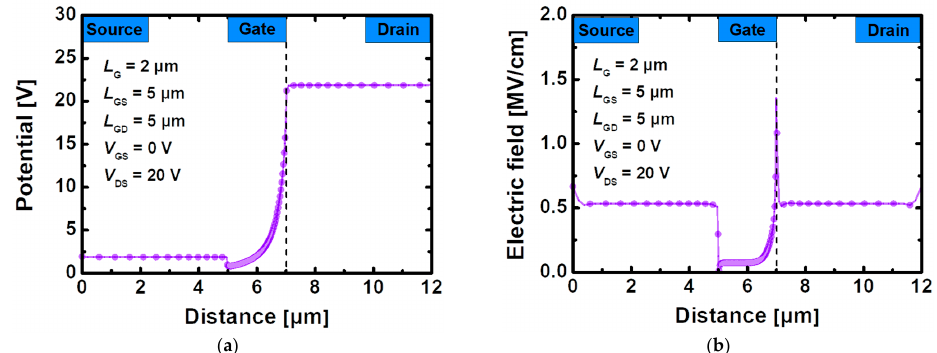
Figure 3. ( a ) Potential and ( b ) electric field in 2DEG layer between GaN and AlGaN under bias V GS = 0 V, V DS = 20 V for recessed-gate GaN MOSFET with the stacked TiO 2 /Si 3 N 4 dual-layer insulator.